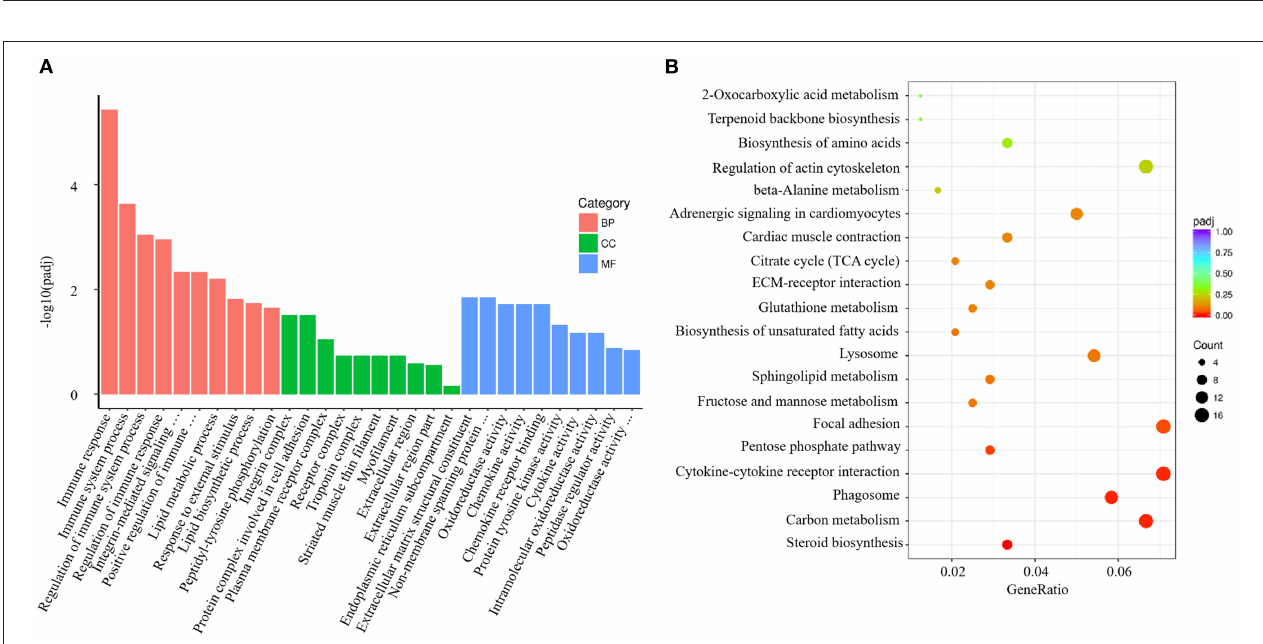
FIGURE 3 | DEGs identified in the gill infected by V. harveyi . The number of DEGs in gill is shown in (A) , and the volcano plot of DEGs in gill is shown in (B) .